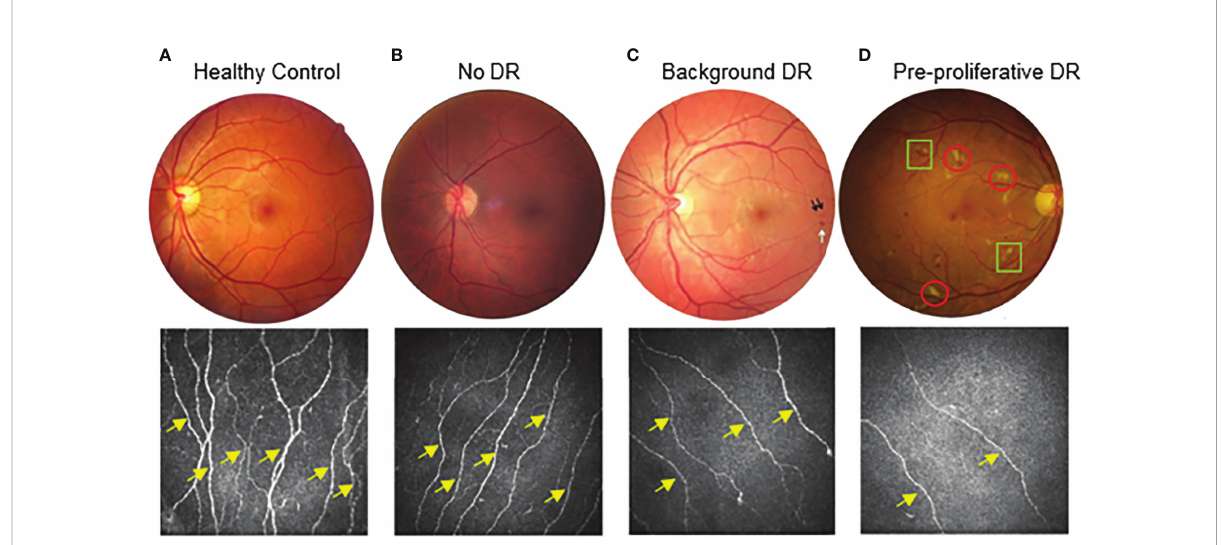
FIGURE 3 Stages of diabetic retinopathy linked to CCM fi ndings from healthy control to pre-proliferative diabetic retinopathy (DR grade 2). Proliferative (DR grade 3) not displayed. (A) demonstrates a healthy control subject. (B) demonstrates a patient with diabetes but no diabetic retinopathy (DR grade 0). (C) demonstrates a patient with background diabetic retinopathy (DR grade 1). Dot haemorrhages (black arrows) and a blot haemorrhage(white arrow) can be seen. (D) demonstrates a patient with diabetes and pre-proliferative diabetic retinopathy (DR grade 2). As well as multiple dot and blot haemorrhages, there are also numerous cotton wool spots (red circles) and intra-retinal microvascular abnormalities (IRMA)(green squares). For the corresponding examples of CCM images, the nerve fi bre density of the main nerves (yellow arrows) decreases as diabetic retinopathy progresses. There is also a clear decrease in the overall nerve fi bre